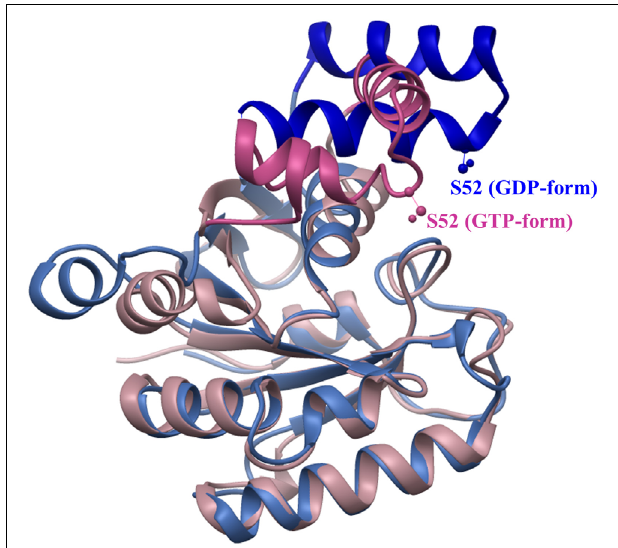
FIGURE 1 | Conformational change of archaeal elongation factor 1A in GDP- and GTP-bound states. Structures of G-domains of aEF1A from Sulfolobus solfataricus in complex with GDP (1SKQ) and Aeropyrum pernix in complex with GTP (3AGJ) were aligned using USCF Chimera (Pettersen et al., 2004). Serine-52 (analog of serine-53 in eEF1A, which is glucosylated by Lgt1-3) is shown in “ball and stick” representation. Regions of aEF1As subjected to major change are drawn in dark blue (GDP-bound) and orchid (GTP-bound) colors, while regions of similar structure are colored in sky-blue (GDP-bound) and pink